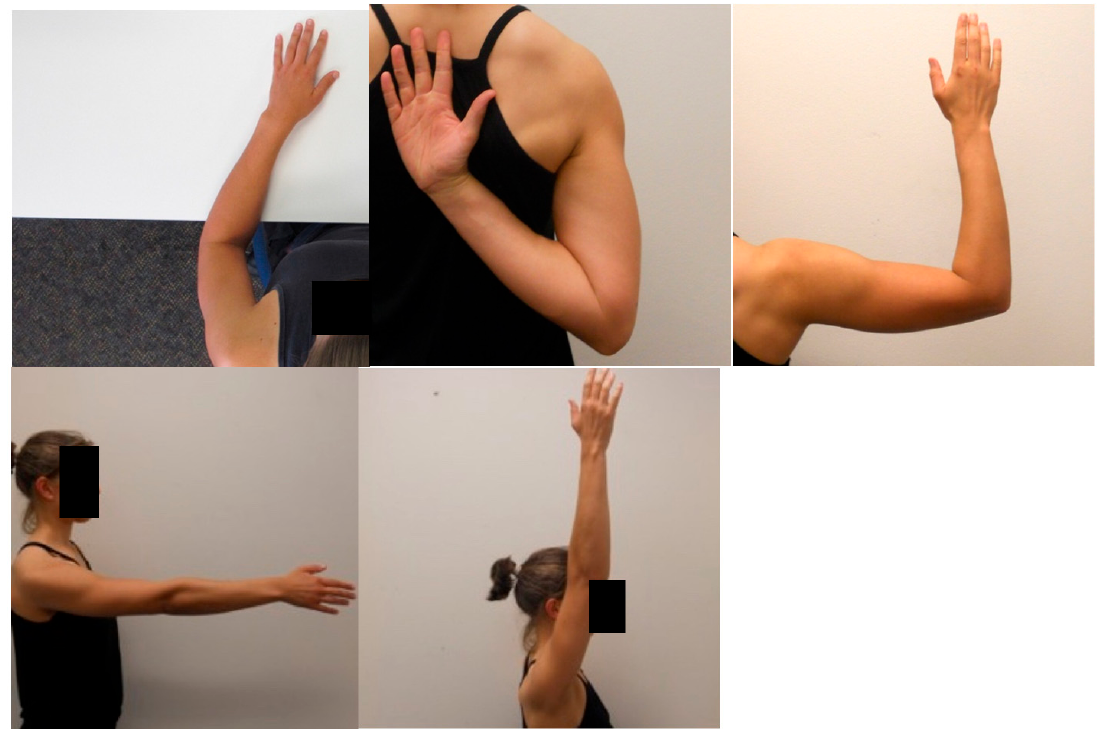
Figure 1. Examples of shoulder images displayed during Shoulder Left/Right Judgement Task.